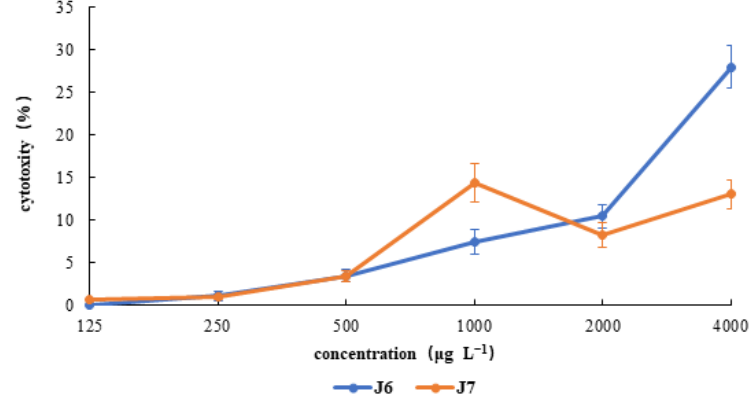
Figure 8. The cytotoxicity of J6/J7 on ECV304 at 24 h.